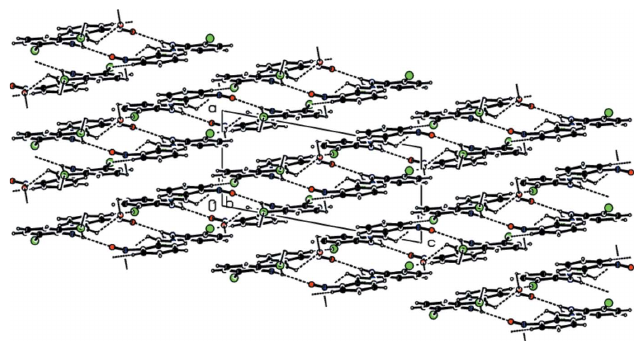
Figure 5 A general view of the crystal packing with the hydrogen bonds and